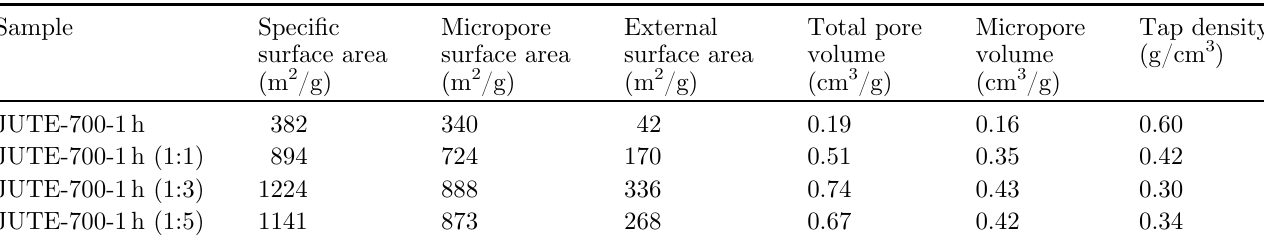
Table 2. Textural properties of jute fi ber based activated carbon.